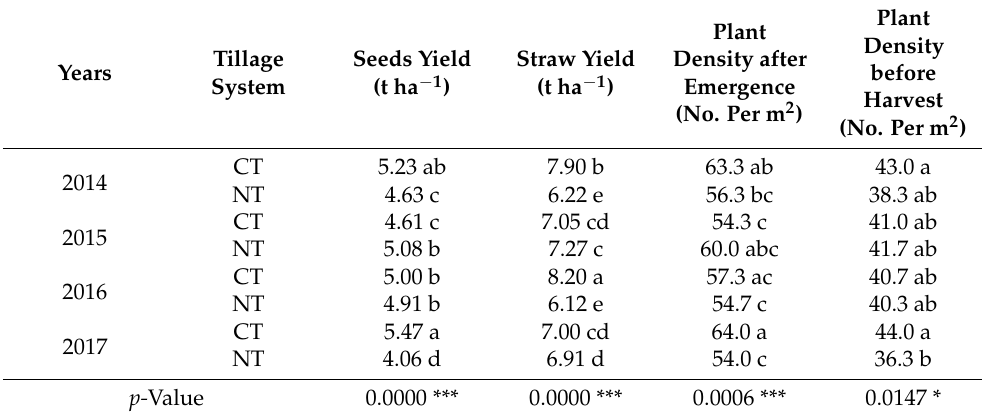
Table 2. Interactive dependencies of tillage systems and years of research in determining winter oilseed rape yield of seeds, straw, and plant density (mean for